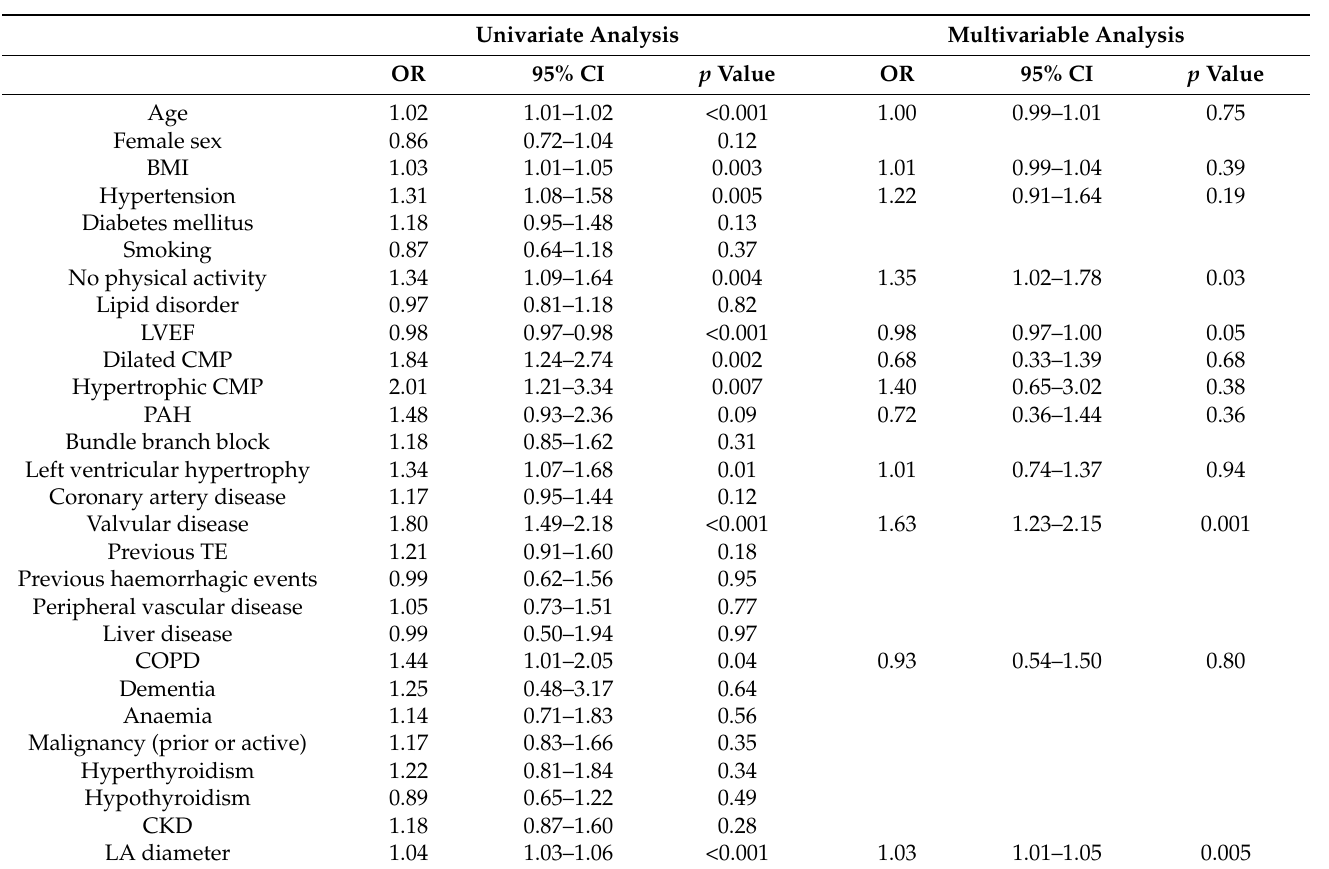
Table 2. Univariate and multivariable logistic regression analysis for factors associated with AF progression at 1 year of